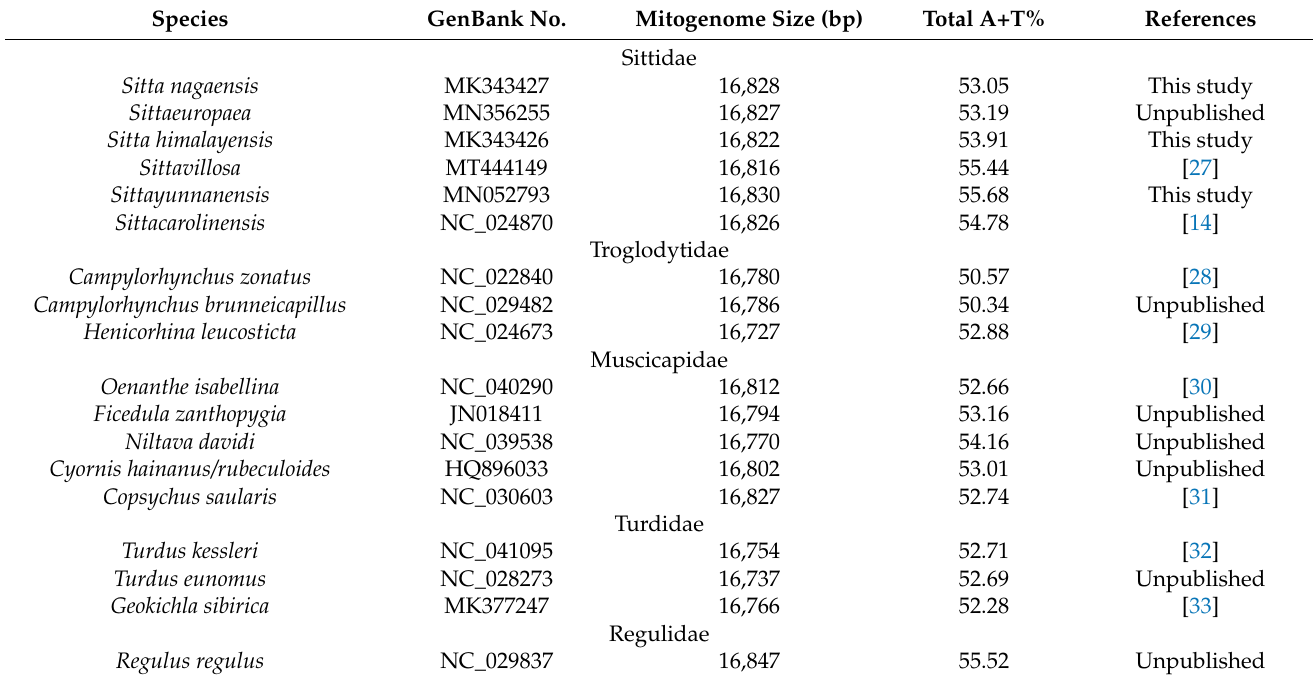
Table 1. List of 18 species used for the phylogenetic analyses in this